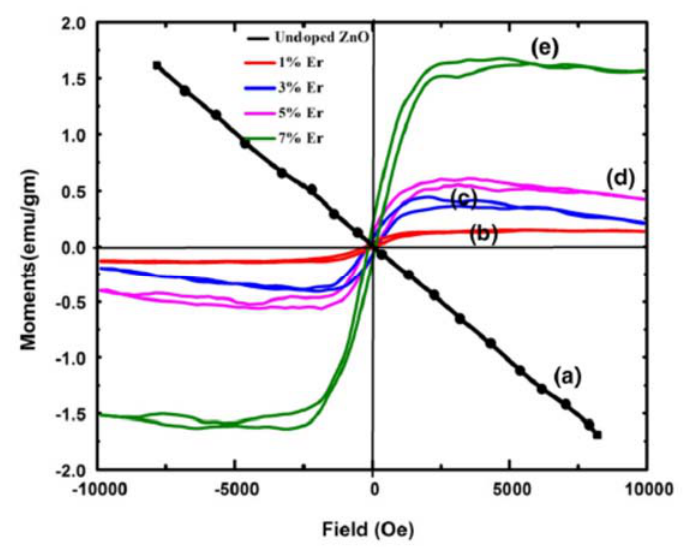
Figure 10. M ‐ H curve of (a) pure, (b) 1%, (c) 3%, (d) 5% and (e) 7% Er doped ZnO (The Figure was reproduced with copyright permission Springer from reference [90]).